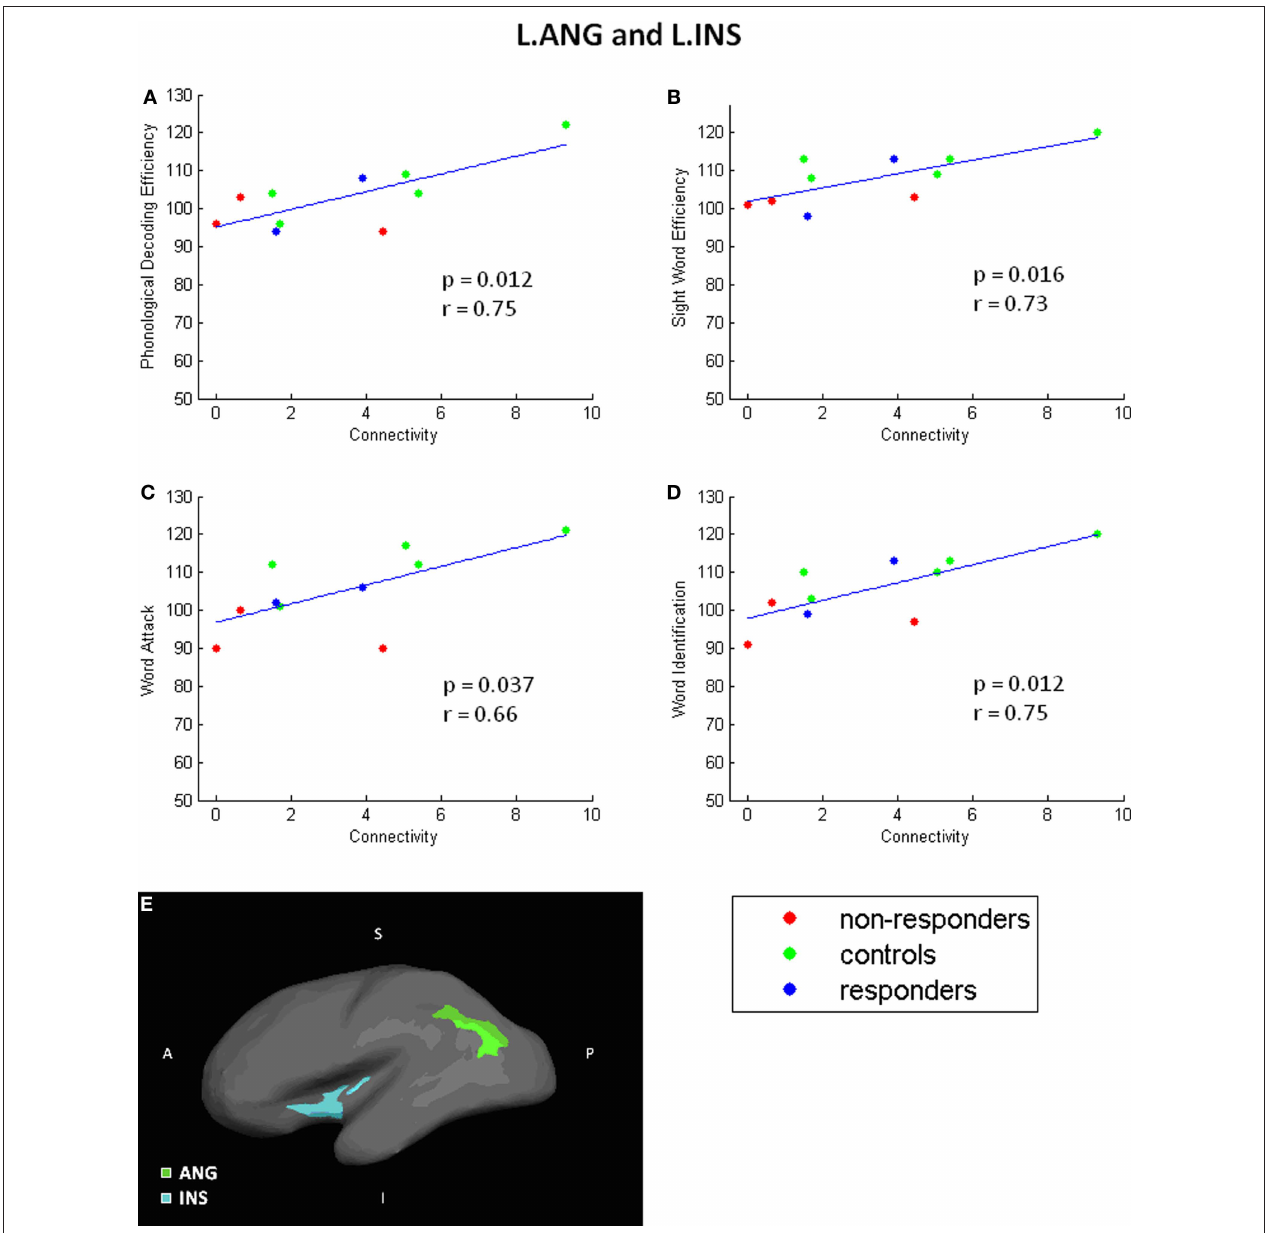
FiguRe 5 | Angular to insula scatterplots. Correlation scatterplots for L.INS and L.ANG. (A–D) Scatterplots showing detailed relationship between connectivity and specific test performances. (e) Locations of L.INS and L.ANG. A single NR participant was identified as an outlier and excluded from this